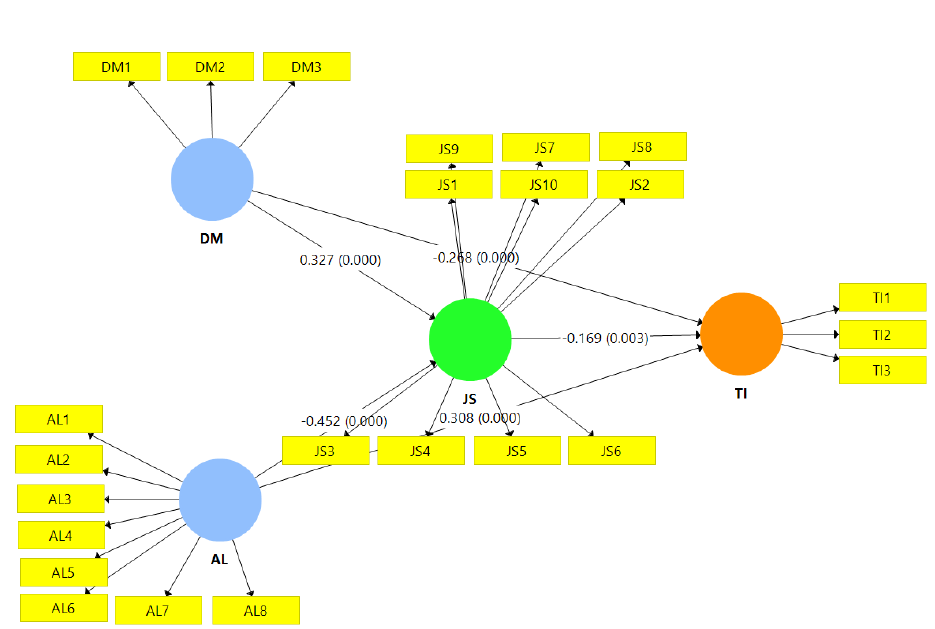
Figure 2: SMART-PLS based SEM